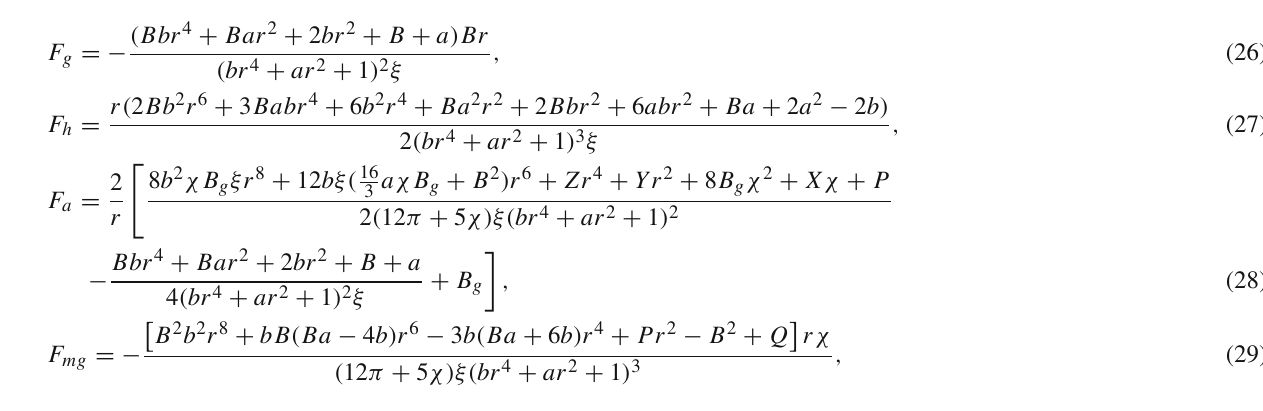
where ξ = (χ + 4 π) , P = ( − B 2 a + ( − a 2 + 4 b ) B − 18 ba ) , Z = [ 8 B g ( a 2 + 2 b )χ 2 + χ + 12 B 2 a π ] , Y = [ 16 aB